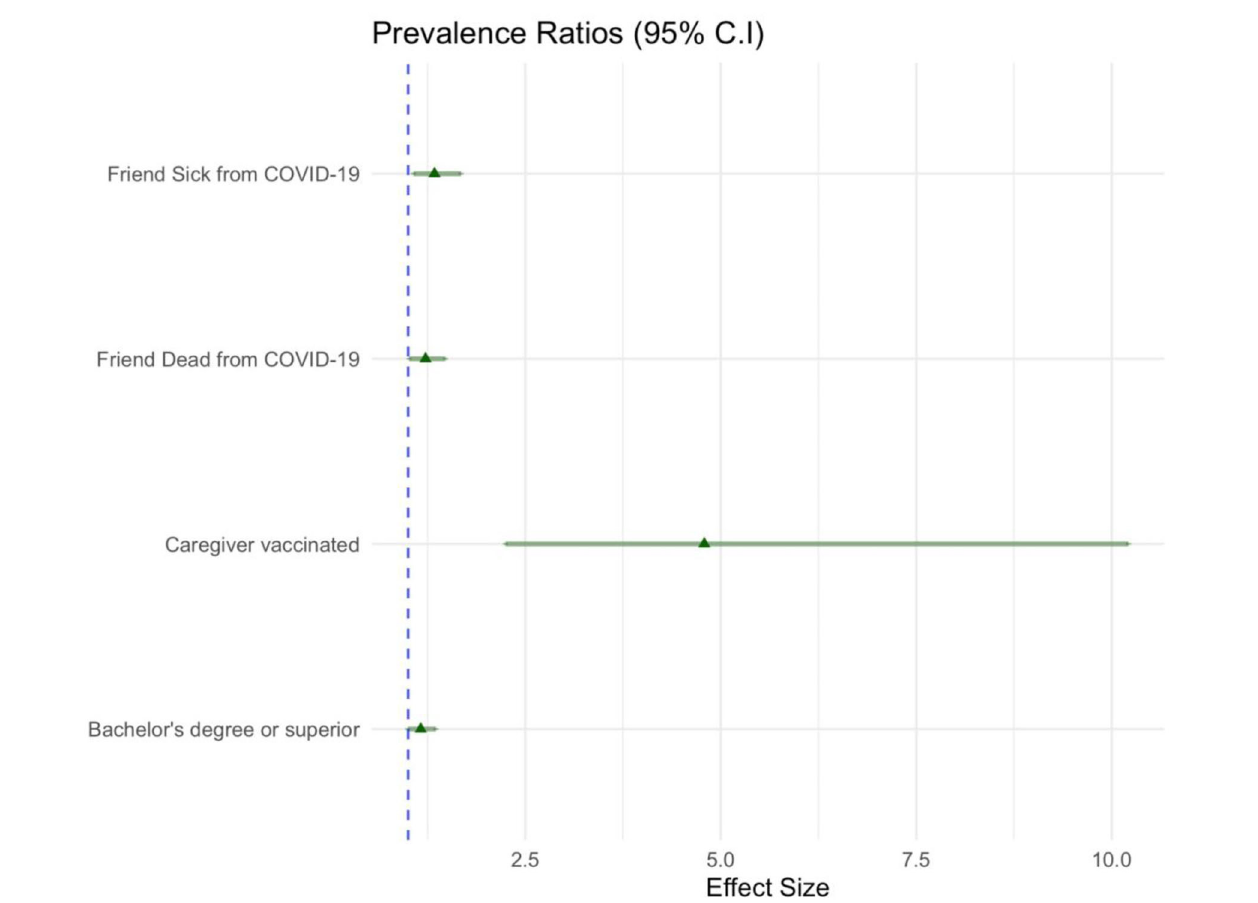
FIGURE 3 | As in Figure 2 , the strength of association between the conditions and the propensity to vaccinate the child are represented here by means of the prevalence ratios (PRs) indicated as triangles and whiskers (95% confidence intervals). Only the conditions positively associated to the propensity to vaccinate the child are displayed. The blue dashed line indicates a prevalence ratio equal to one (the condition displayed in the plot has an equal effect related to the condition with which is compared). Again, the condition “Caregiver vaccinated” is compared with its reference level “Caregiver Not Vaccinated”; the conditions “Friend Sick from COVID-19” and “Friend Dead from COVID-19” are compared with the reference level “neither of the two”; the condition “Bachelor’s degree or superior,” referring to the caregiver’s level of education, is compared with its reference level “lower level of